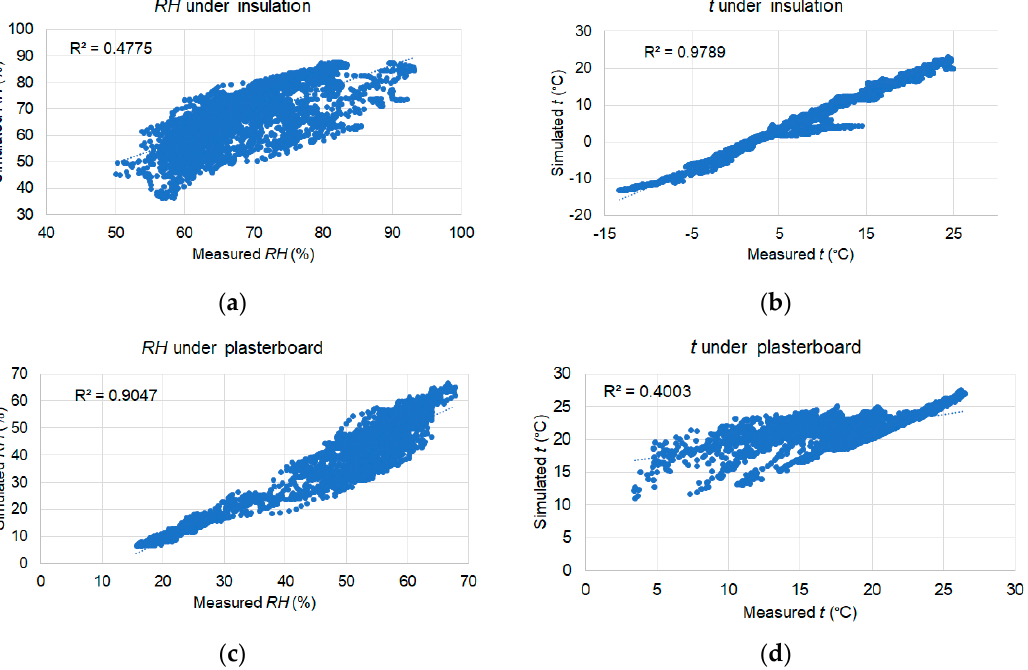
Figure 20. Correlation between simulated and measured RH and t in the living room wall: ( a ) RH between dolomite and insulation; ( b ) t between dolomite and insulation; ( c ) RH between the insulation and vapor barrier; ( d ) t between the insulation and vapor barrier.